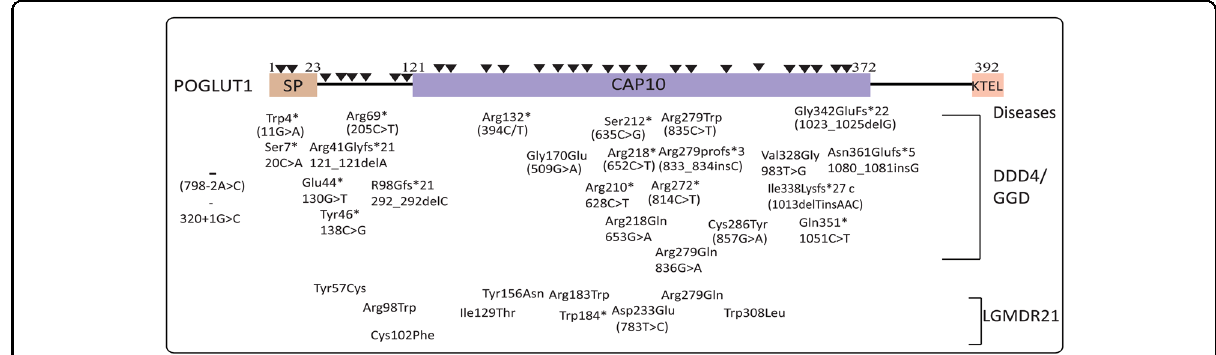
Fig. 5 POGLUT1 mutations associated to cause human diseases. Several mutations of POGLUT1 have been implicated in human DDD4/GGD and LGMDR21. So far, only two nonsense mutations are reported in a signal peptide of POGLUT1 in DDD4/GGD patients. Most of the missense, nonsense, and frameshift variants of POGLUT1 are reported in the CAP10 catalytic domain, which harbors many essential amino acids required for O - glucosylation activity. A single change of essential residues of CAP10 domain can abolish O -glucosyltransferase activity as previously observed. The nonsense and frameshift mutations are resulted either in mRNA decay or the formation of a truncated POGLUT1 leading to DDD4/GGD and LGMDR21